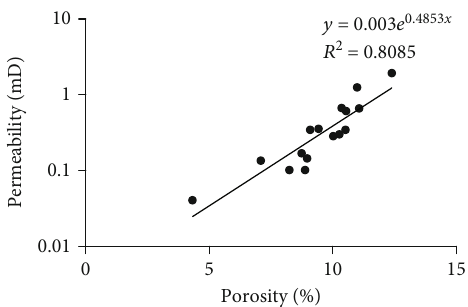
Figure 3: Porosity versus permeability of tight sandstones in the Ordos